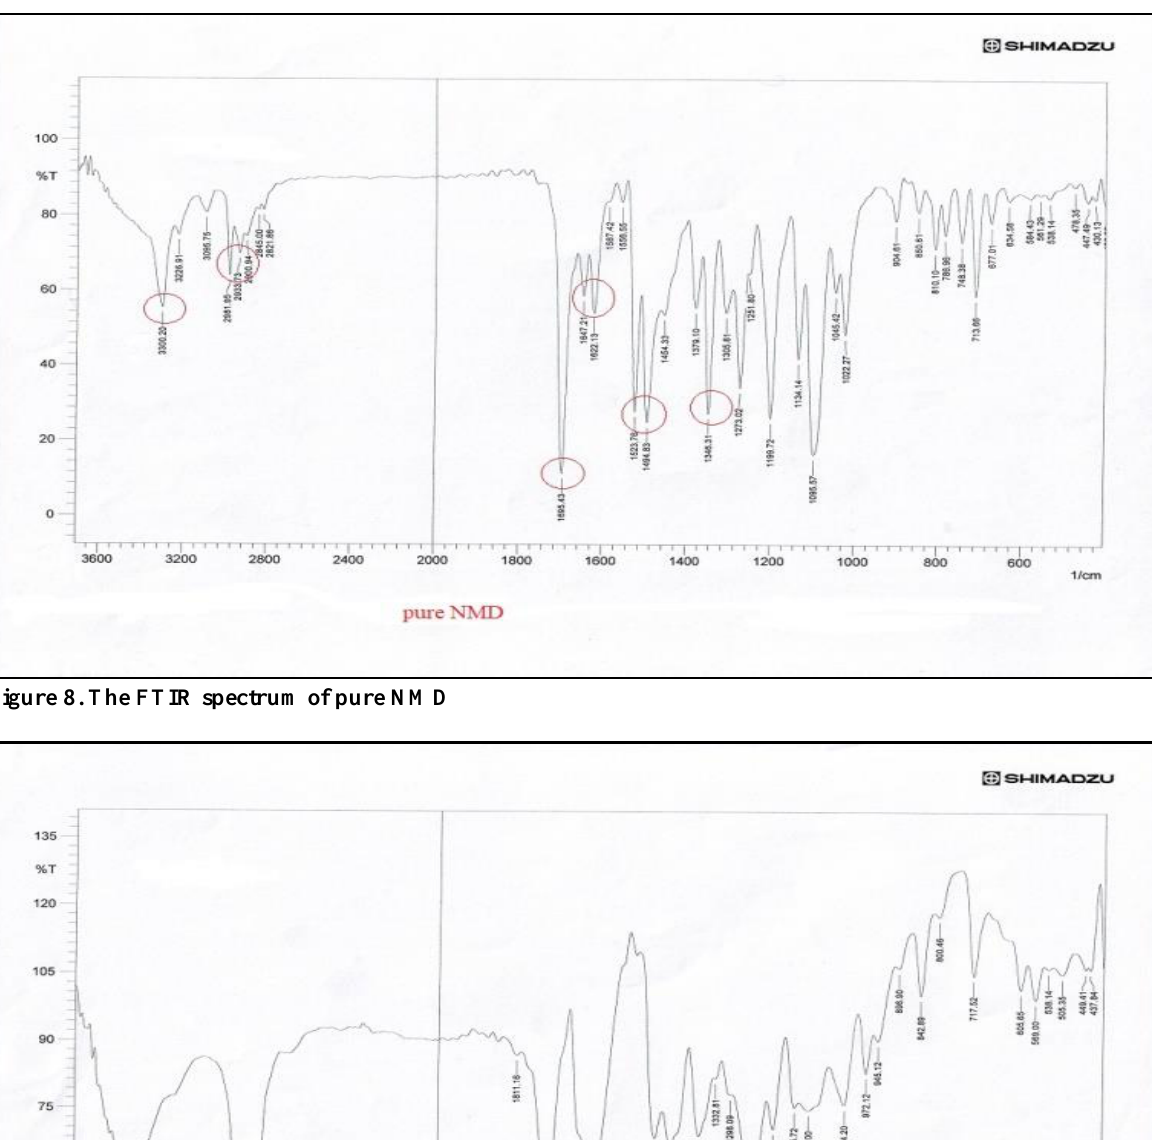
Figure 9. FTIR spectrum of